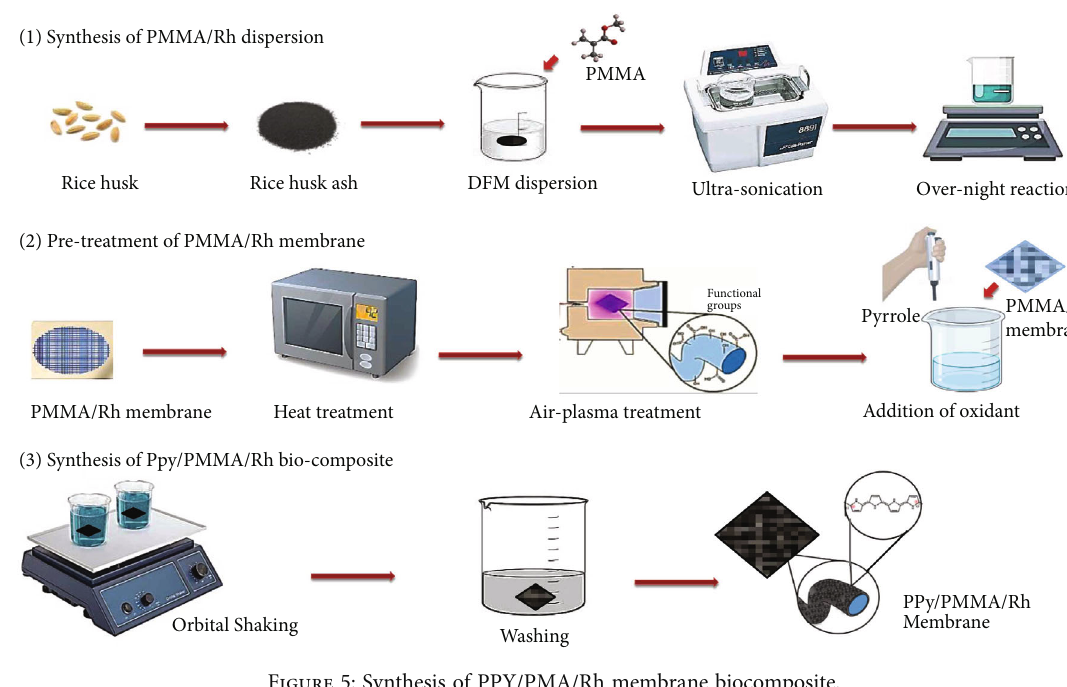
Figure 5: Synthesis of PPY/PMA/Rh membrane biocomposite.